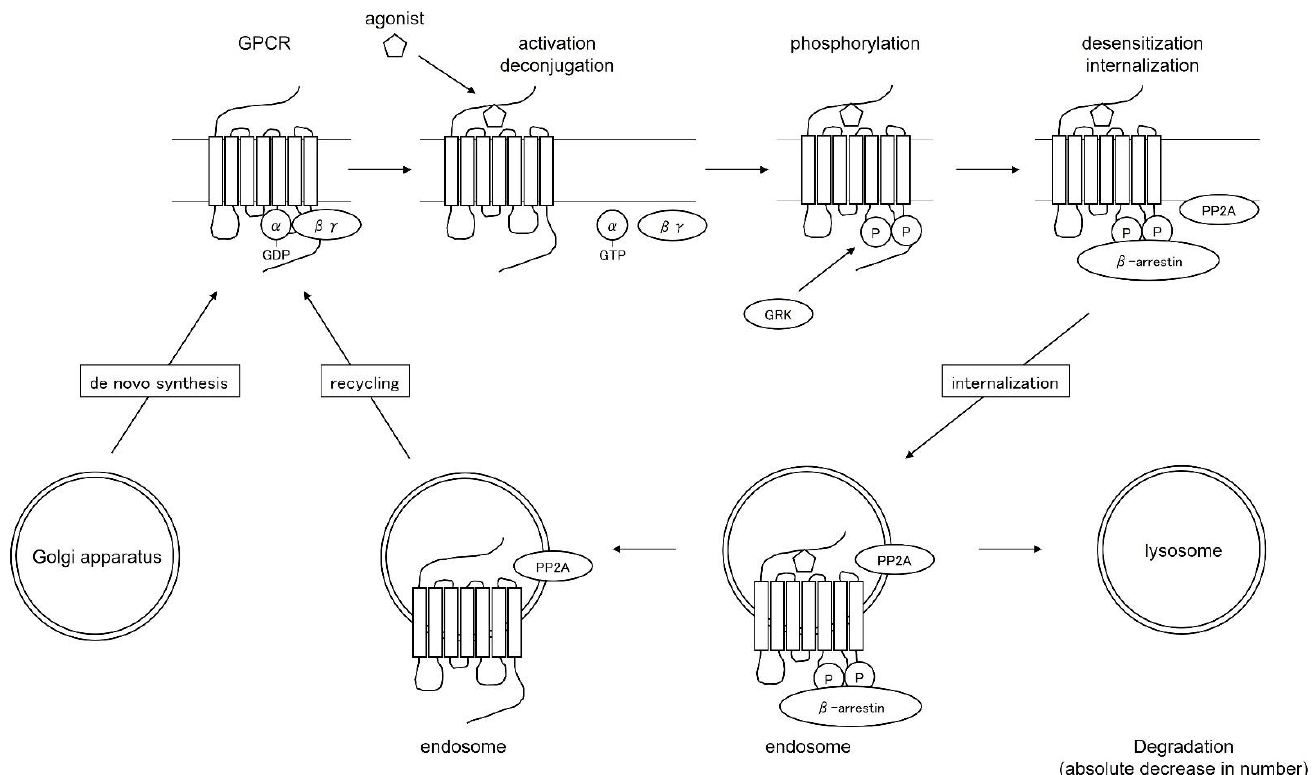
Figure 1. Regulation of function and distribution of G-protein-coupled receptors.